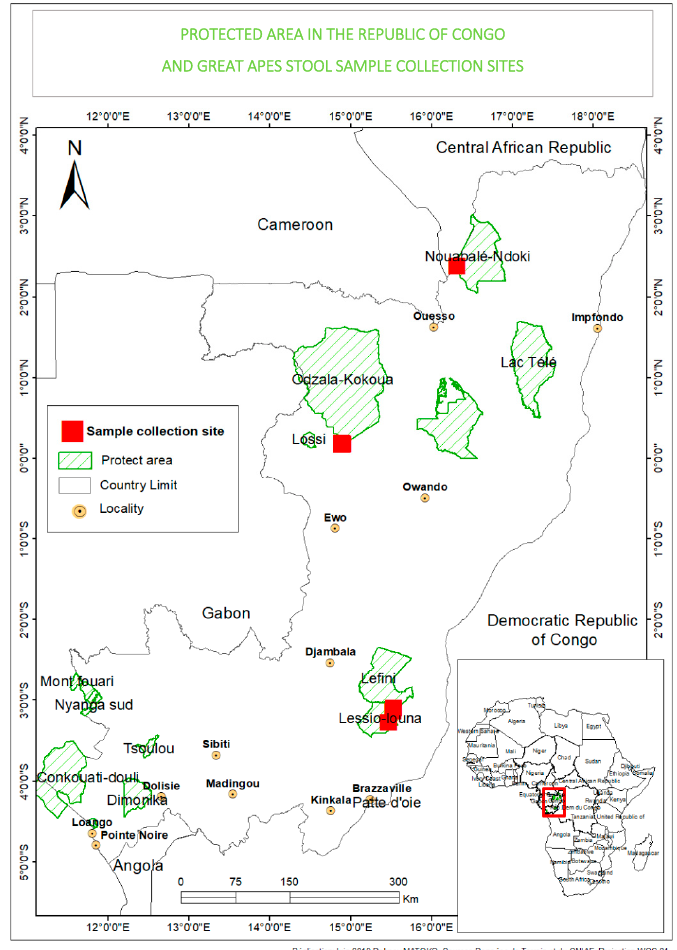
Figure 1. Protected areas in the Republic of Congo and fecal sample collection sites.